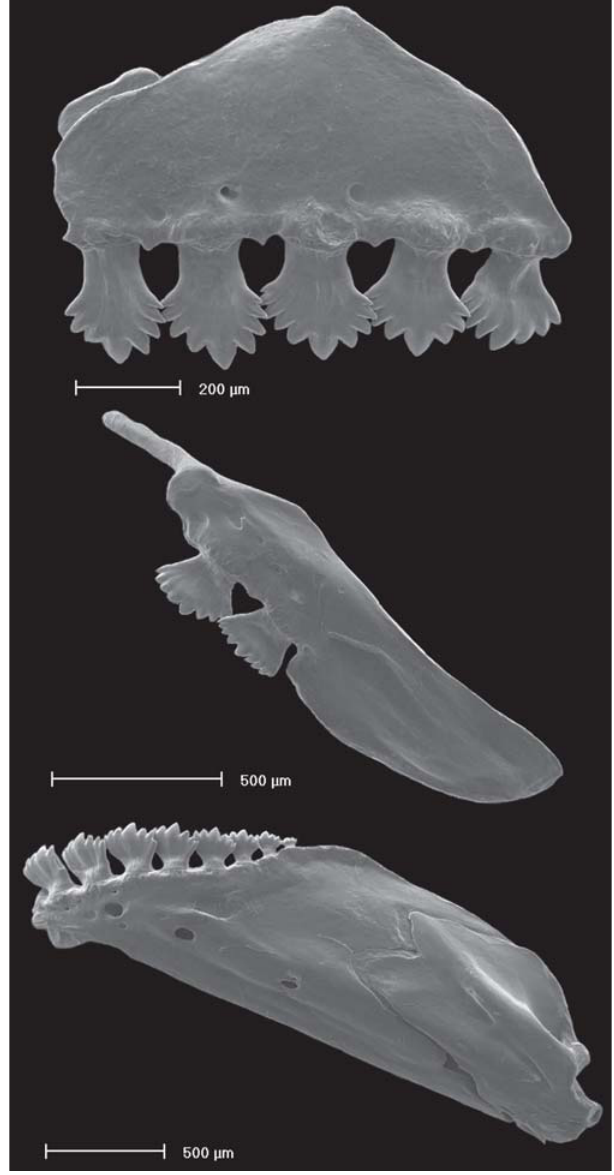
Fig. 27. Dentition of Odontostilbe parecis , MCP 37319, male 32.8 mm SL. SEM photograph of left side premaxilla (top), maxilla (middle), and dentary